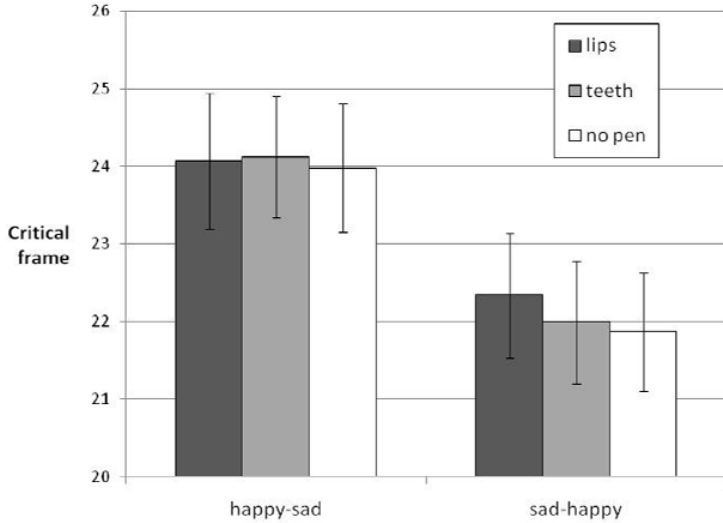
Figure 2. Means of critical frames averaged across participants, separately for the two morph sequences and three pen conditions, for expressions changing between happy and sad. Error bars depict